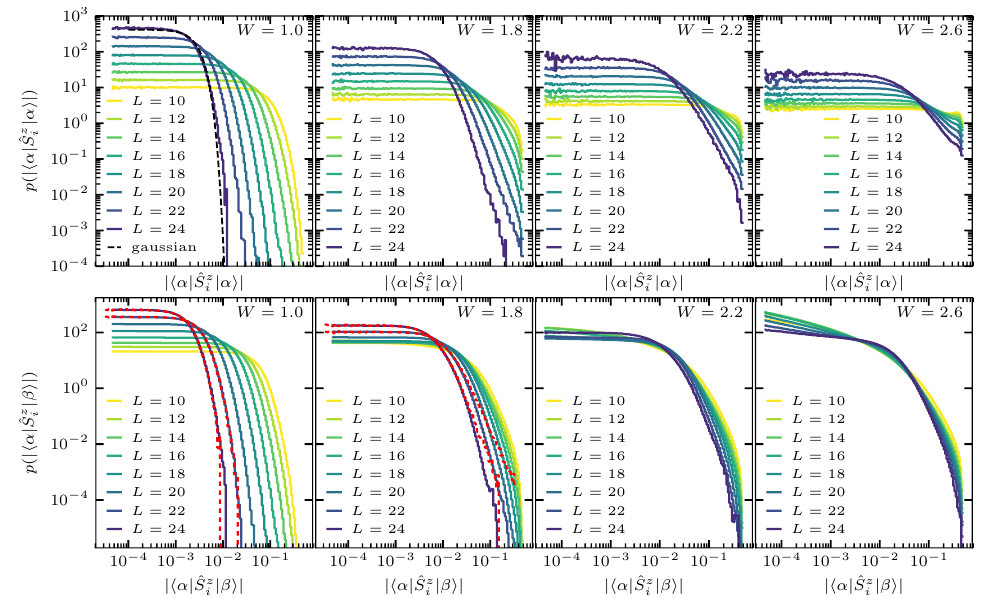
Figure 8: Distribution of diagonal (top) and offdiagonal (bottom) matrix elements of the local ˆ S z operator as a function of disorder strength W in the eigenbasis {| α 〉} i of the Hamiltonian. For each disorder realization, 50 eigenstates closest to middle of the many-body spectrum. For each system size and disorder strength 10 2 ...10 4 disorder realizations are included, as well as all positions i in the chain. Note that for | α 〉 the distribution for each disorder realization the diagonal matrix elements 〈 α | ˆ S z i has a (slightly) nonzero mean, which we subtracted here (cf. discussion in Ref. [ 82 ] ). The red dashed histograms in the bottom row for W = 1.0 and W = 1.8 correspond (cid:112) (cid:0) 〈 α | ˆ (cid:1) | α 〉 / S z to the (rescaled) distribution of the diagonal matrix elements 2 p 2 i for comparison. For stronger disorder, the distributions of diagonal and offdiagonal matrix elements are so strikingly different that we do not show them in the same panel